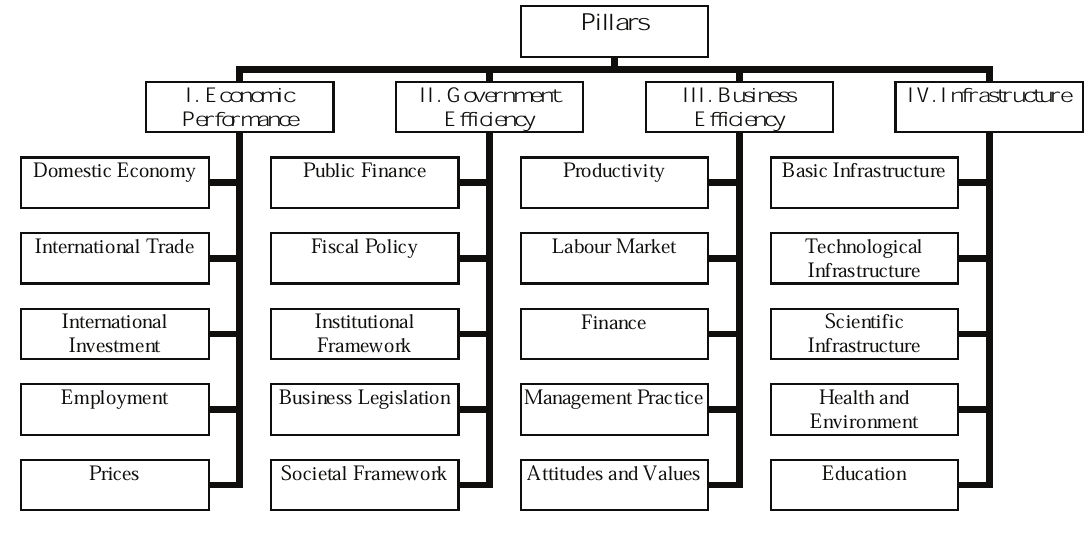
Fig. 6. Four pillars of competitiveness (Garelli